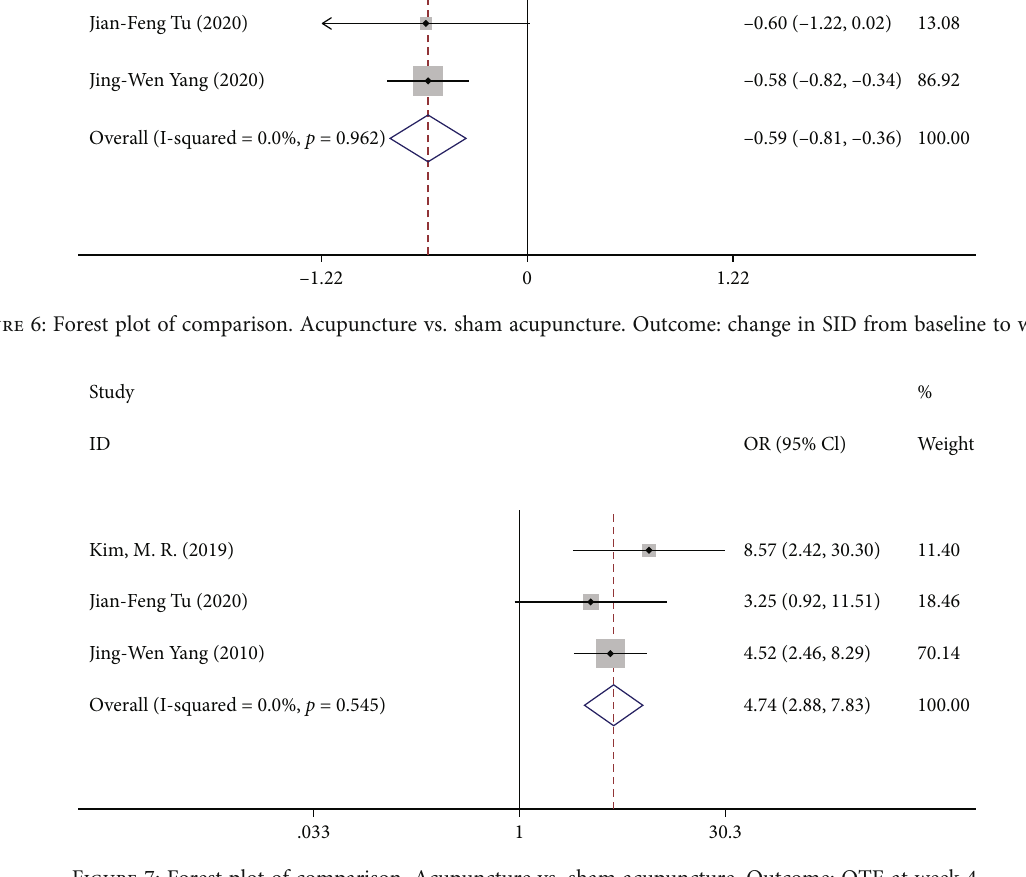
Figure 7: Forest plot of comparison. Acupuncture vs. sham acupuncture. Outcome: OTE at week 4.